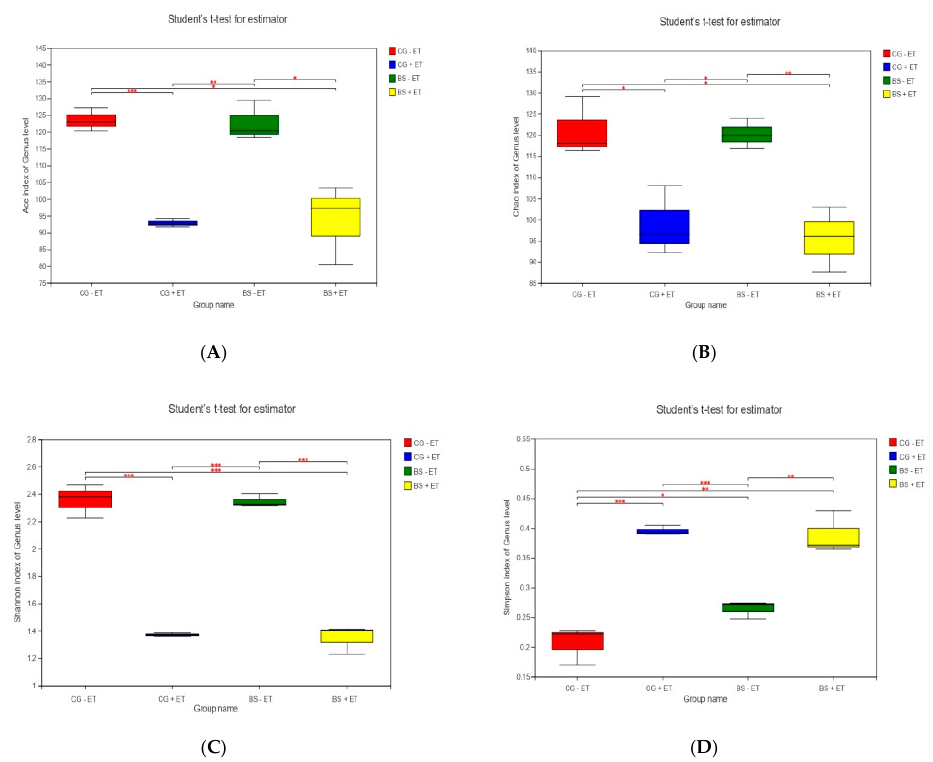
Figure 1. Effects of treatments on alpha diversity index. ( A ) Ace index, ( B ) Chao 1 index, ( C ) Shannon index and ( D ) Simpson index. *, **, *** represent significant difference. There were 129, 98, 124 and 96 OTUs observed in groups CG − ET, CG + ET, BS − ET, and BS + ET, respectively, of which 80 were common in all experimental groups. More- over, a total of 13 unique OTUs were detected within CG − ET, CG + ET, BS − ET, and BS + ET (6, 0, 4, and 3, respectively, Figure 2).